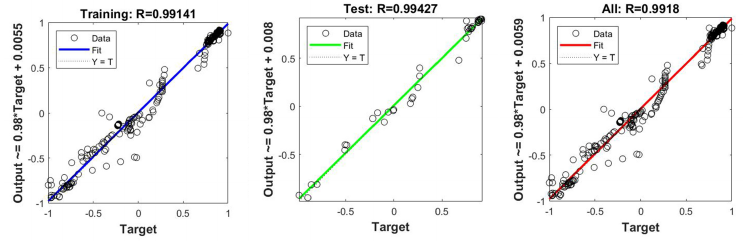
Figure 5. Regression prediction of wheat-growth-cycle prediction model.